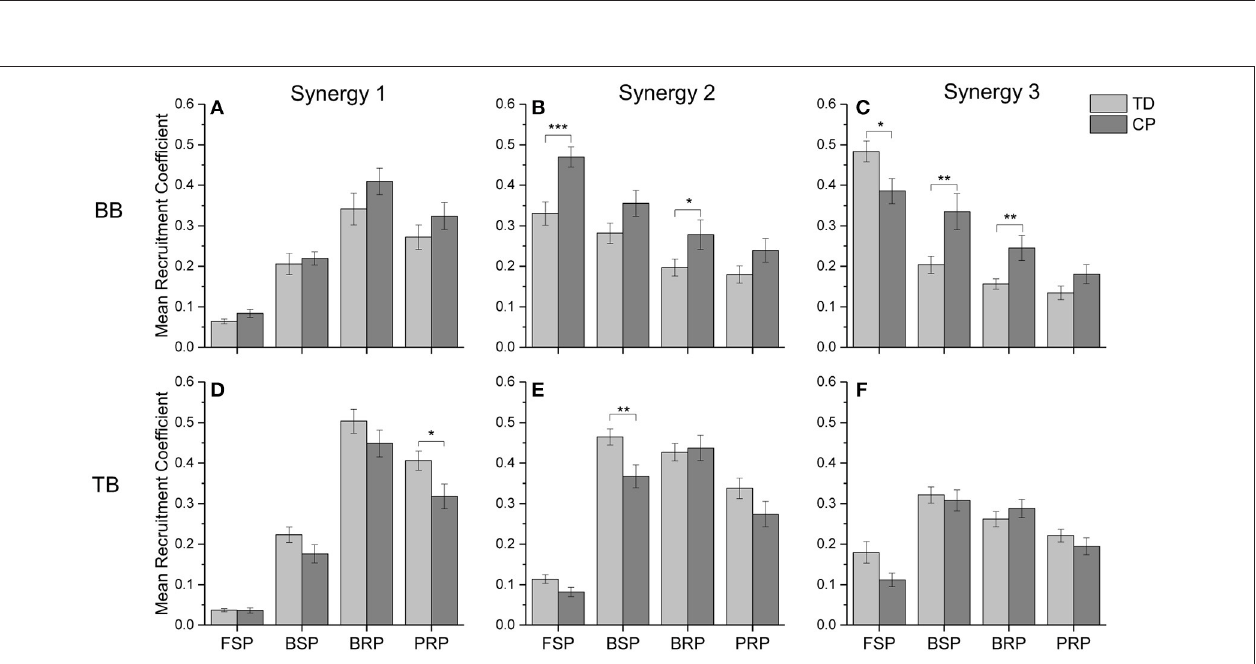
Frontiers in Neurology | www.frontiersin.org